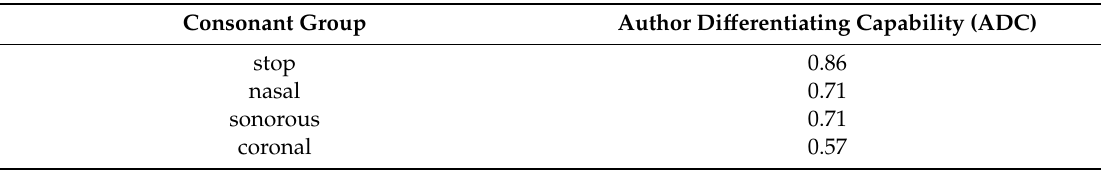
Table 5. The author-di ff erentiating capability of consonant